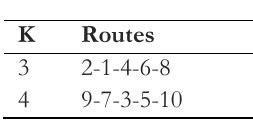
Table 5. Routes of health workers with 10 patients.